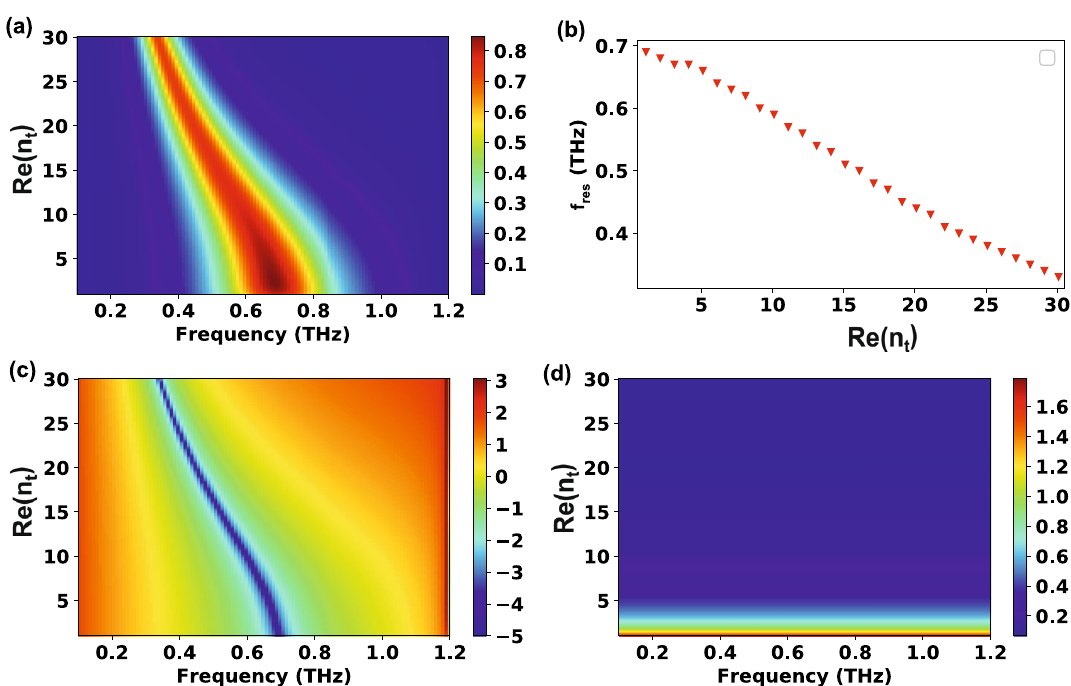
Figure 3. Effect of the real part of the thin film refractive index ( Re ( n t ) ) on the transmission characteristics of a four-layer system. The geometry of the slot antennas: w = 25 µ m, l = 150 µ m, h = 70nm, p x = 127 µ m, p y = 180 µ m and d = 240 nm . The refractive index of the substrate is fixed at 2.0. ( a ) Transmission as functions of frequency and Re ( n t ) . ( b ) Relationship between the resonance frequency and Re ( n t ) . Re ( n t ) versus ( c ) log ( Im ( W 1 + W 3 )) and ( d ) 1 / F y (cid:31) (cid:31)